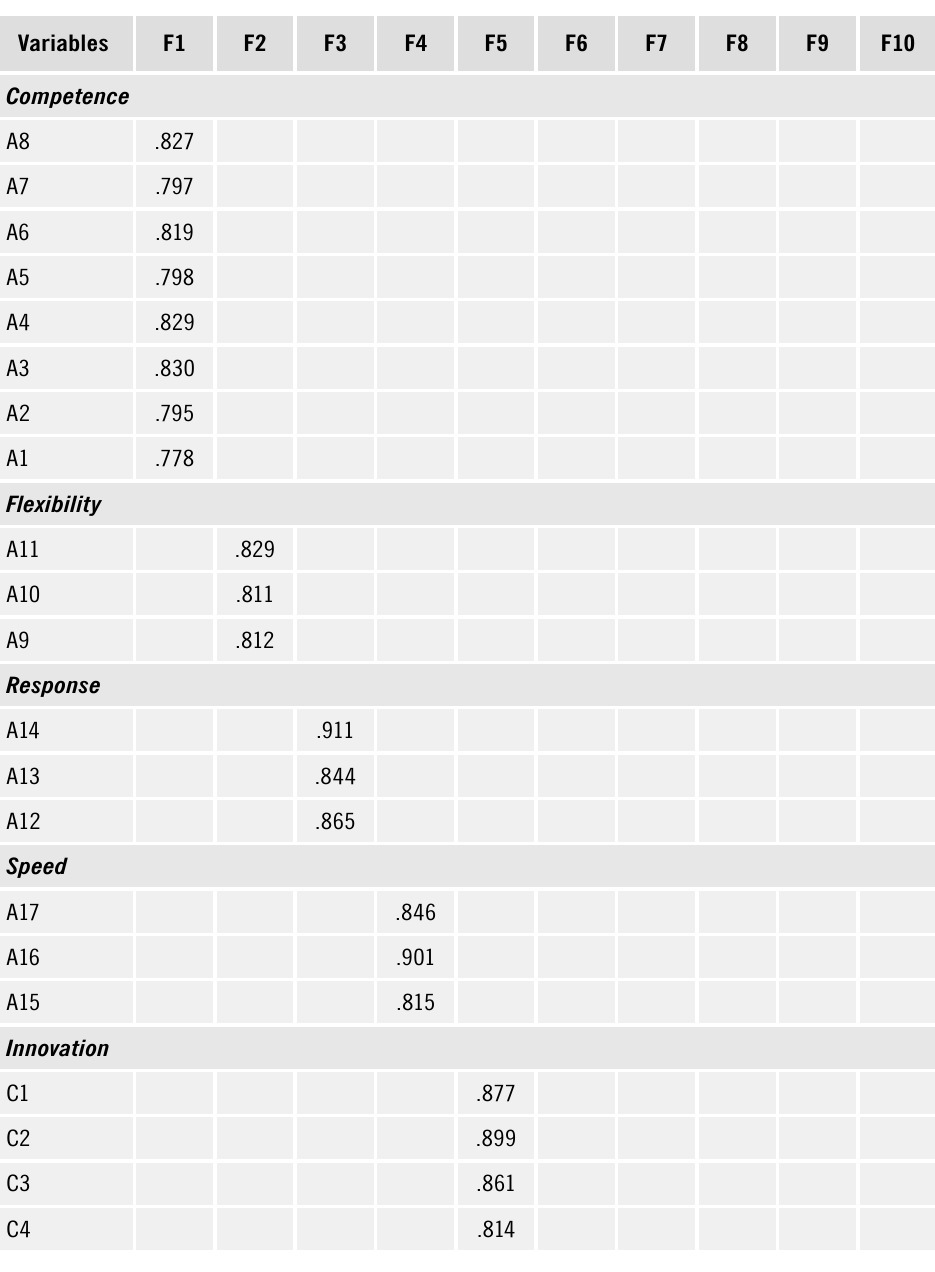
Table 2. Confirmatory factor analysis: factor loads